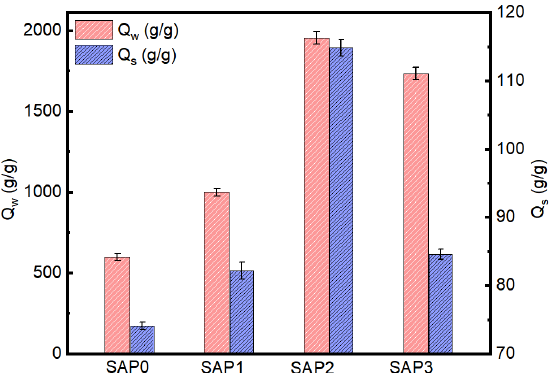
Figure 5. Absorption capacities of deionized water and saline water for SAP0, SAP1, SAP2, and SAP3.